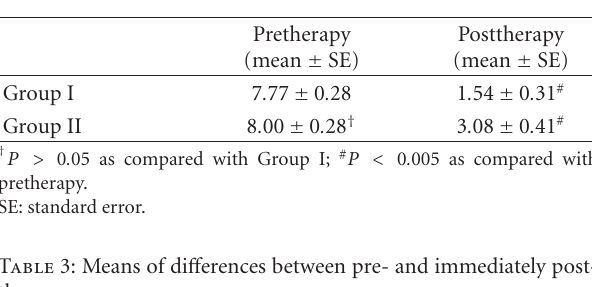
Table 3: Means of di ff erences between pre- and immediately post- therapy.